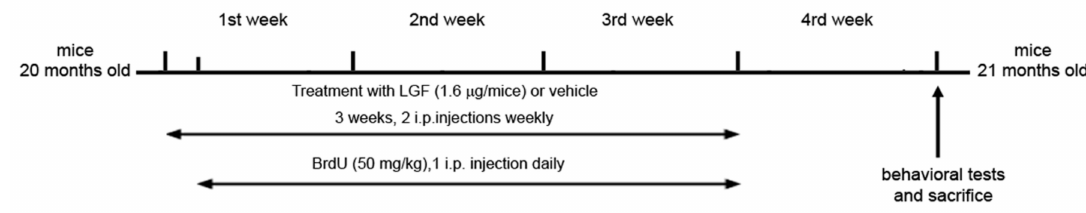
Figure 7. Representative scheme showing the methodological procedure followed for the administration of LGF or vehicle to 20 months old WT and APPswe